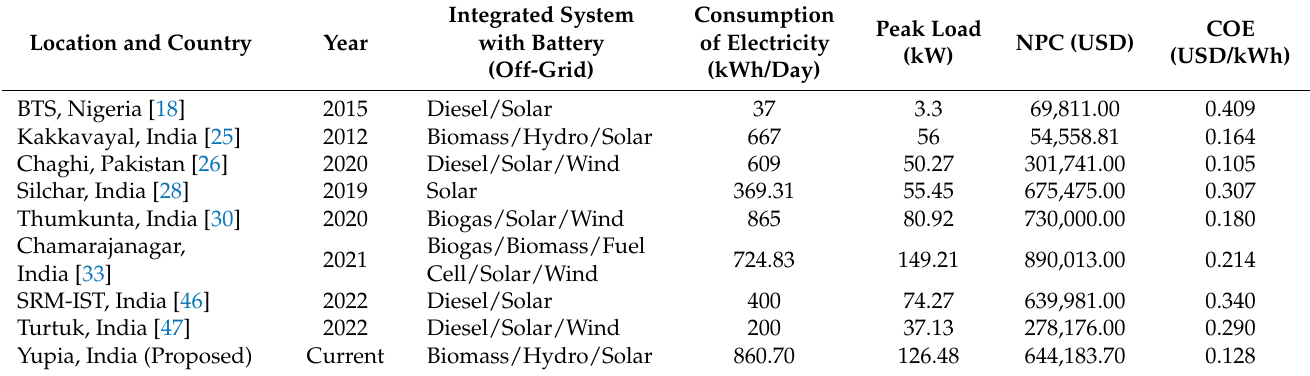
Table 1. Comparative analysis of the present research work with the selected existing studies.